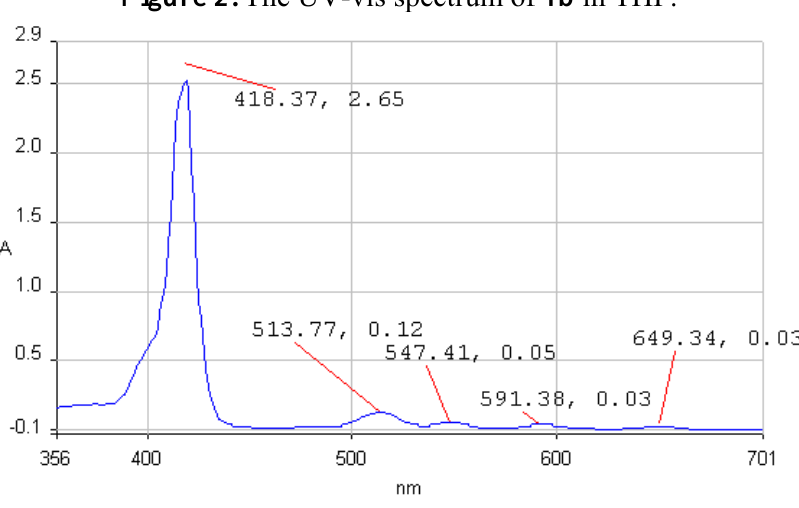
Figure 2. The UV-vis spectrum of 1b in THF.